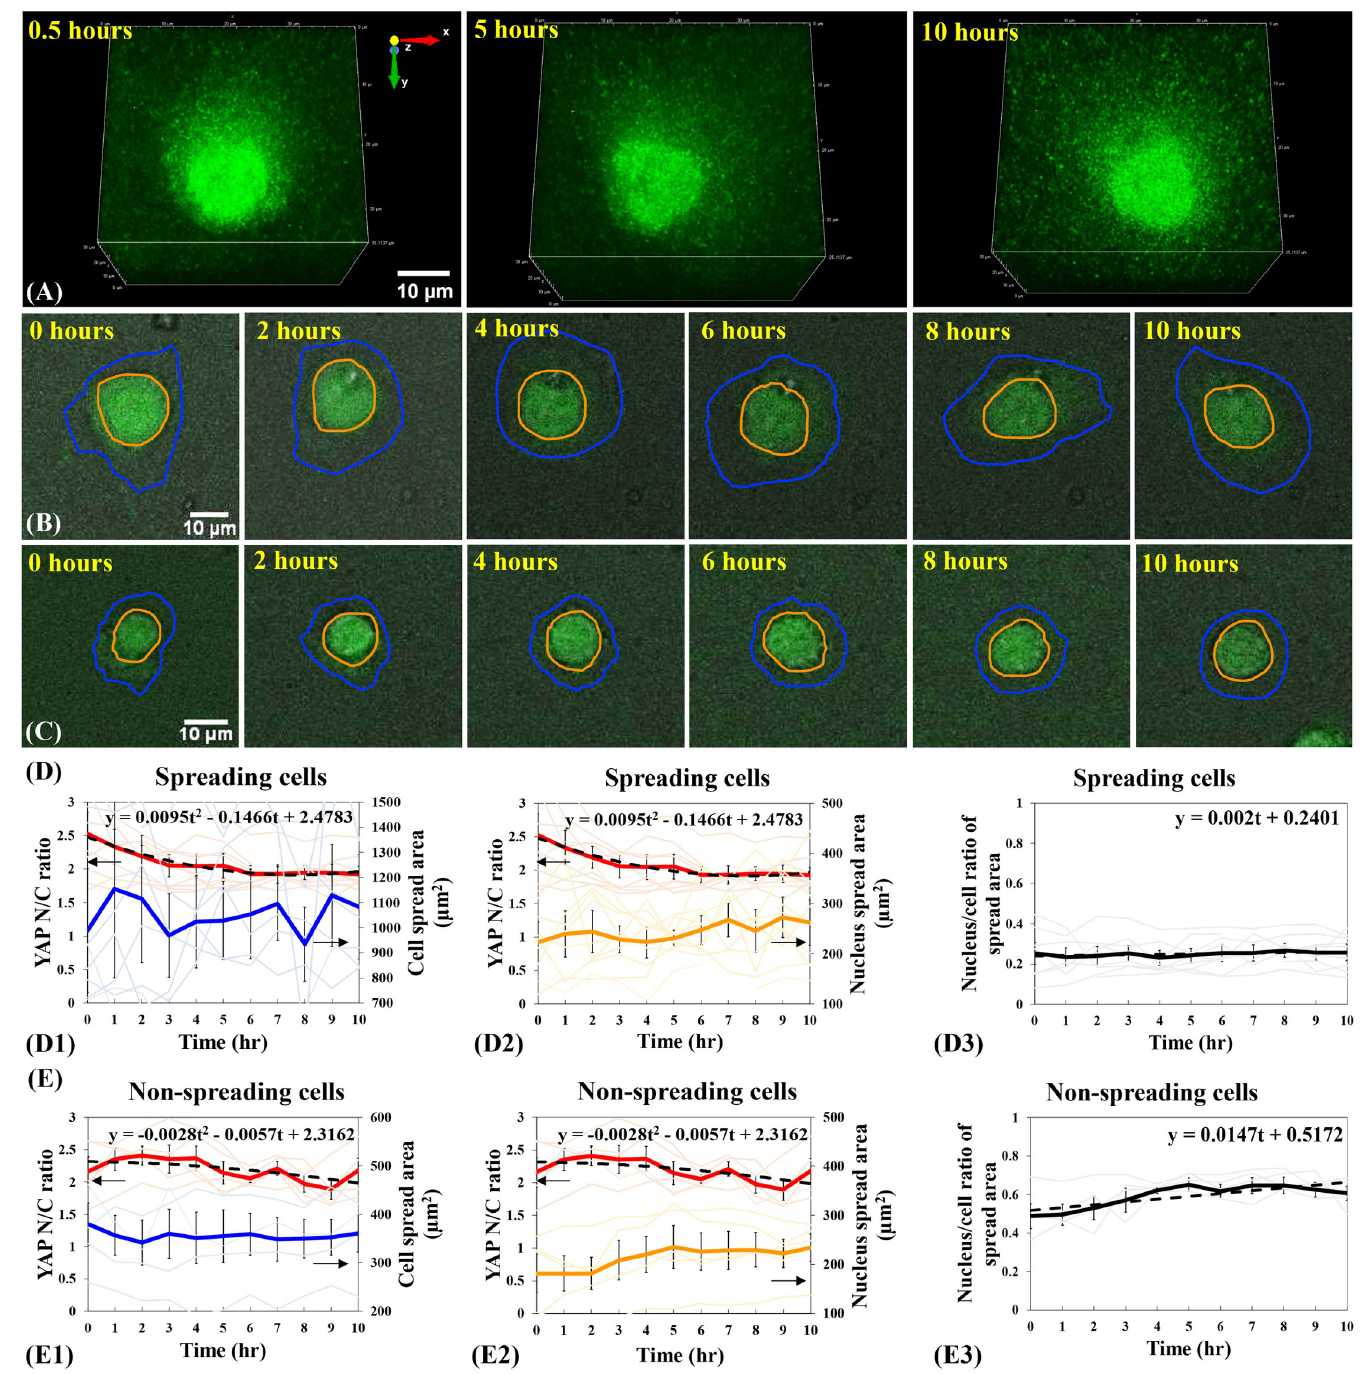
Fig 5. YAP N/C ratio and cell spreading states of single B2B cells on 40-kPa hydrogels substrates. ( A ) 3D fluorescent YAP image stack of the single spreading B2B cell (B) at 0.5 th , 5 th and 10 th hour. ( B ) 10-hr time-lapse filmstrip of a single B2B cell on 40-kPa substrates during the spreading process. Note: cell flattens down and YAP N/C ratio changes from 3.14 at 0 th hour to 2.48 at 10 th hour. ( C ) 10-hr time-lapse image stack of a non-spreading single cell. The YAP N/C ratio changed from 1.95 at 0th hour to 1.89 at 10th hour. ( D ) YAP N/C ratio compared with nucleus/cell-body area of single spreading cells (n = 10). The average YAP N/C ratio (red bold line; n = 10) changed from 2.53 ± 0.32 to 1.93 ± 0.12 (p-value = 0.0118 � ; D1 ). The average normalized cell area (blue bold line; n = 10) increased from 988.25 ± 247.34 μ m 2 to 1082.84 ± 207.46 μ m 2 (p-value = 0.6487 (ns); D1 ) and the average normalized nucleus area (orange bold line; n = 10) augmented from 220.70 ± 41.35 μ m 2 to 262.37 ± 45.64 μ m 2 (p-value = 0.3220 (ns); D2 ). The average nucleus-spread-area/cell-spread-area ratio changed from 0.25 ± 0.05 to 0.26 ± 0.04 (p-value = 0.9317 (ns)),